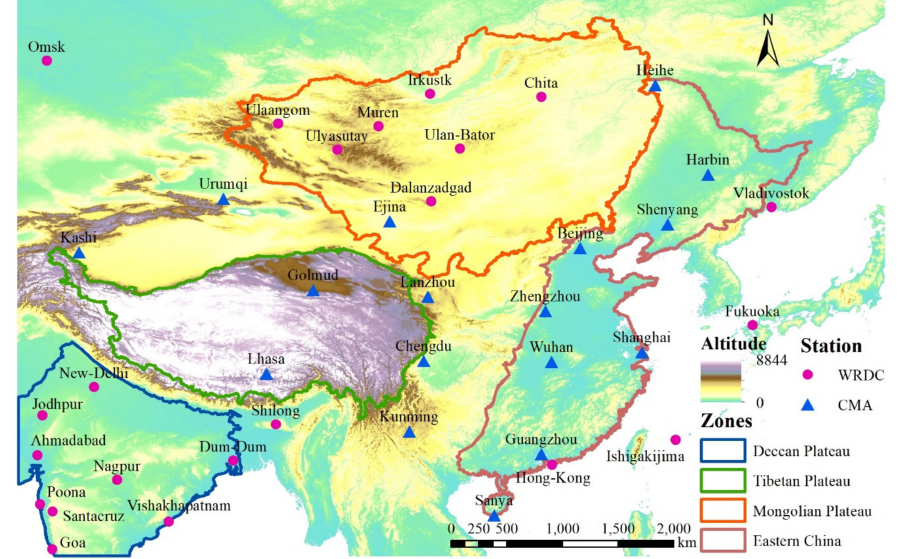
Figure 1. Locations of used radiation stations and zone boundary for statistical analysis. Hourly, daily and monthly measurements of di ff use radiation are available for 17 stations (blue triangles) from China Meteorological Administration (CMA). Daily and monthly measurements for other stations (red circles) are obtained from World Radiation Data Center (WRDC). Detailed information of all stations can be found in Table S1. Four polygons define the boundary of Deccan Plateau, Tibetan Plateau, Mongolian Plateau and Eastern China for regional analysis in this